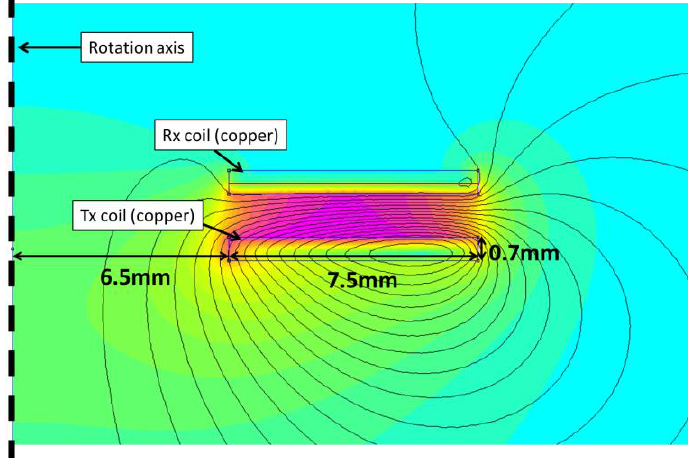
Figure 5. FEMM Model of the power transmission component of the